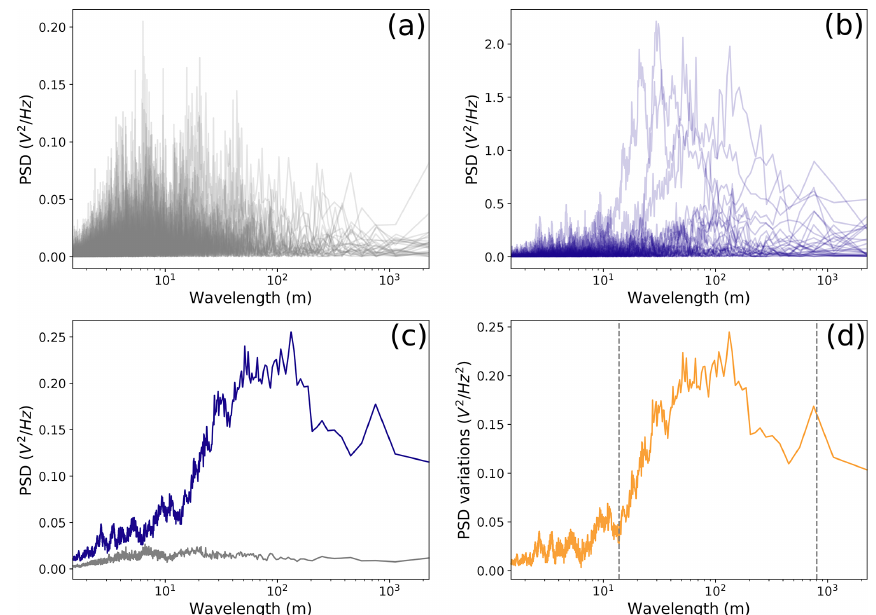
Figure 4. Determination of the frequency high cutoff by analyzing the power spectra of (a) 30 random background signals and (b) 30 wave signals. (c) Power spectral density (PSD) averages for the selected background (gray) and wave (blue) signals. (d) Difference between the two curves shown in (c) . The gray dotted lines indicate the low- and high-cutoff wavelengths (13.7 and 800m,